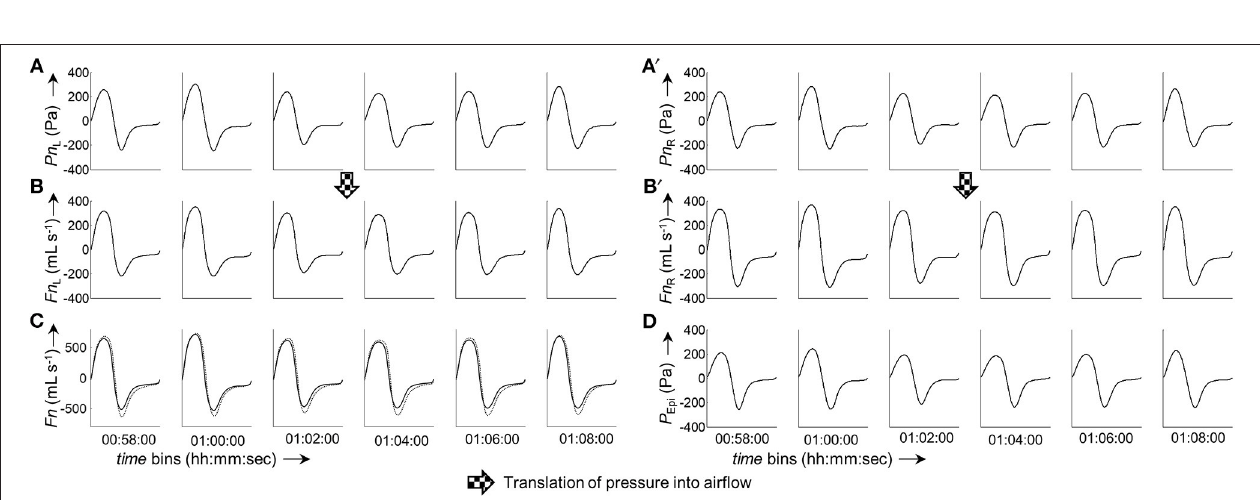
R , solid line) and airflow from a flow meter +